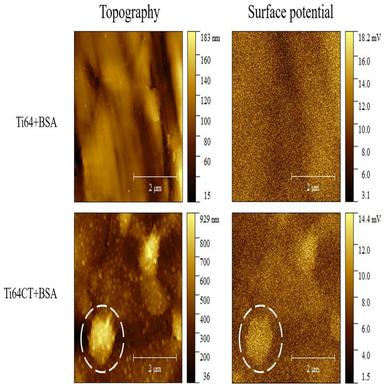
Topography (left column) and surface potential images (right column) of Ti64 + BSA (top row) and Ti64CT + BSA (bottom row) surfaces. Scan size is 5x5 lm.